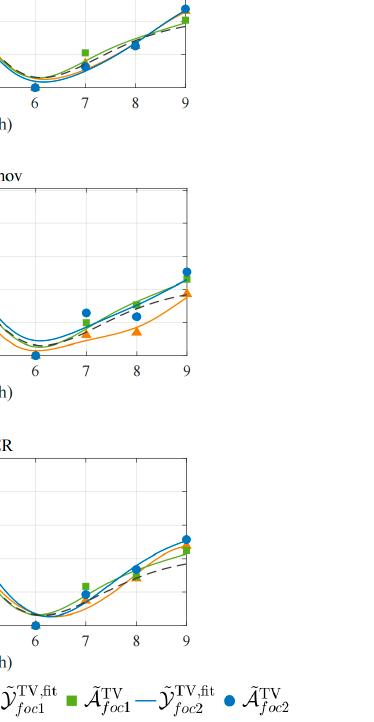
Figure 8. Comparison of the normalized reconstruction pixel values of the heart region under three models and the real area trend. models and the real area